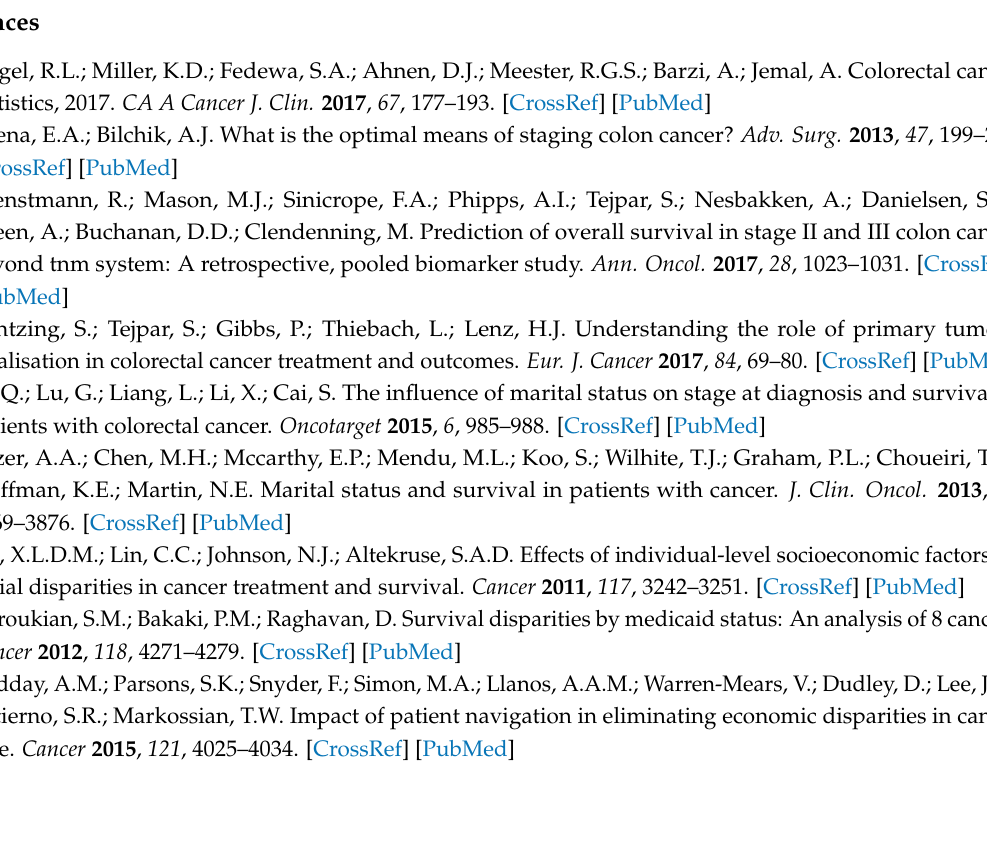
Table S1: Multivariable Cox regression analyses of independent prognostic factors in non-metastatic colon cancer. Author Contributions: Conceptualization, Q.L. (Qi Liu), Q.L. (Qingguo Li) and X.L.; Data curation, D.L.; Formal analysis, Q.L. (Qi Liu) and Q.L. (Qingguo Li); Funding acquisition, Q.L. (Qingguo Li) and X.L.; Investigation, D.L.; Methodology, Q.L. (Qi Liu); Project administration, X.L.; Resources, Q.L. (Qi Liu) and D.L.; Software, D.L.; Supervision, S.C. and X.L.; Validation, Q.L. (Qingguo Li); Visualization, X.L.; Writing—original draft, Q.L. (Qi Liu); Writing—review & editing, Q.L. (Qi Liu), S.C., Q.L. (Qingguo Li) and